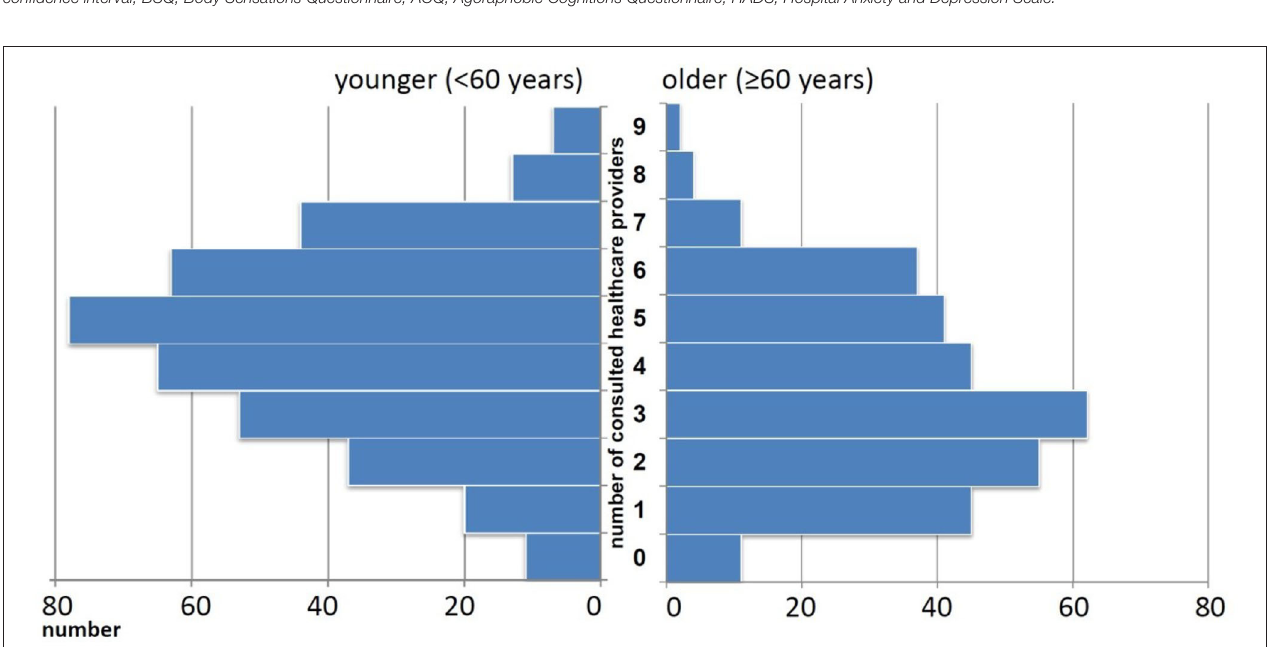
FIGURE 1 | Number of different healthcare providers consulted for